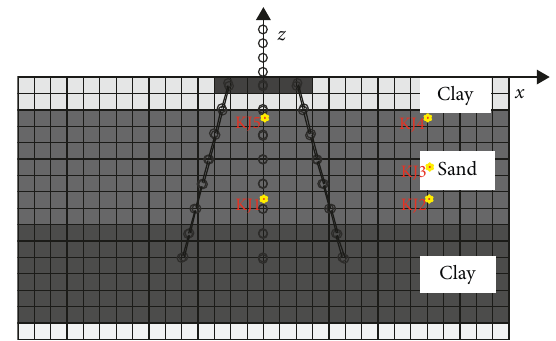
Figure 3: Numerical simulation model corresponding to three soil